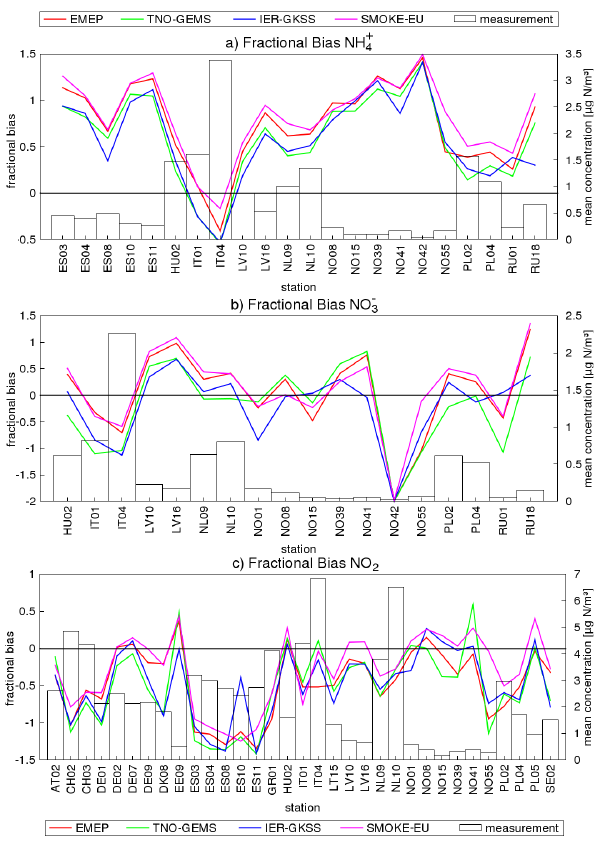
Fig. 16. Fractional bias of modelled NH + concentrations using four different emission datasets compared to daily mean observations from EMEP measurement stations for the year 2000 (see also Tables 6 and